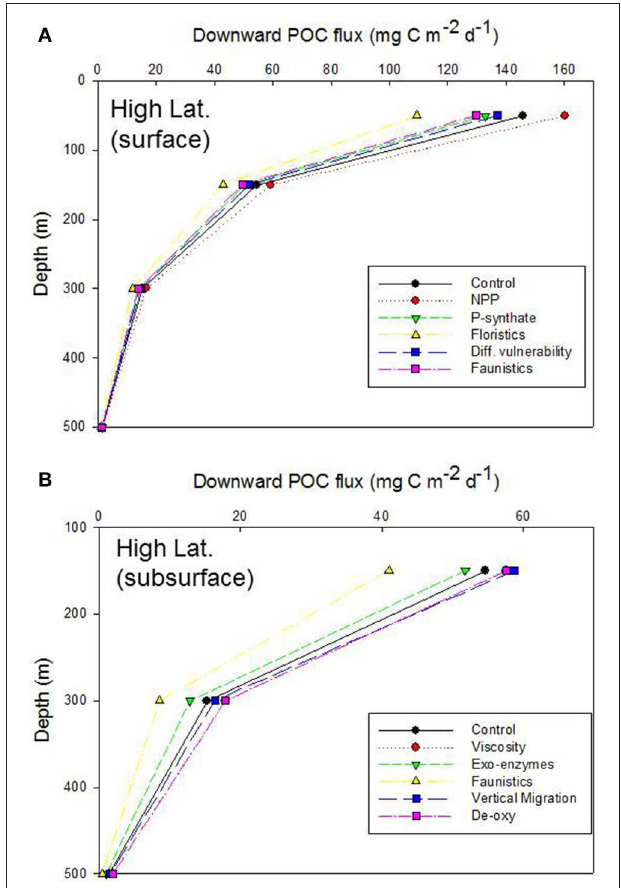
FIGURE 5 | Vertical profile of projected POC flux for the control run, low latitude case. The additional simulations for (A,B) are as described in Figures 4A,B . As for Figure 4B , the “Viscosity” profile is overlaid by “De-oxygenation.” In the case of the NPP run, NPP is decreased for low latitudes (Bopp et al., 2013; Marañón et al., 2014). Note, the convergence of fluxes at 150m depth is due to relatively little influence of altered subsurface processes over 20m depth (i.e., 130m deep Ez, Table 2